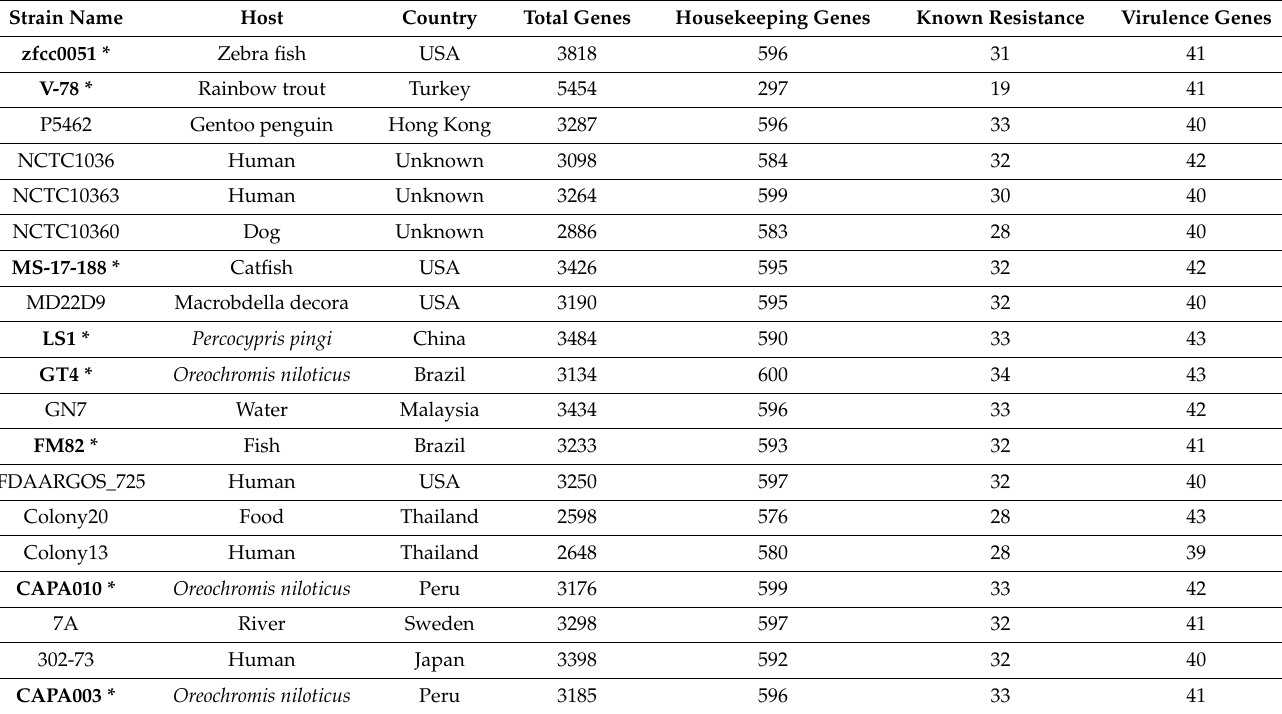
Table 1. P. shigelloides strains compared in this study.